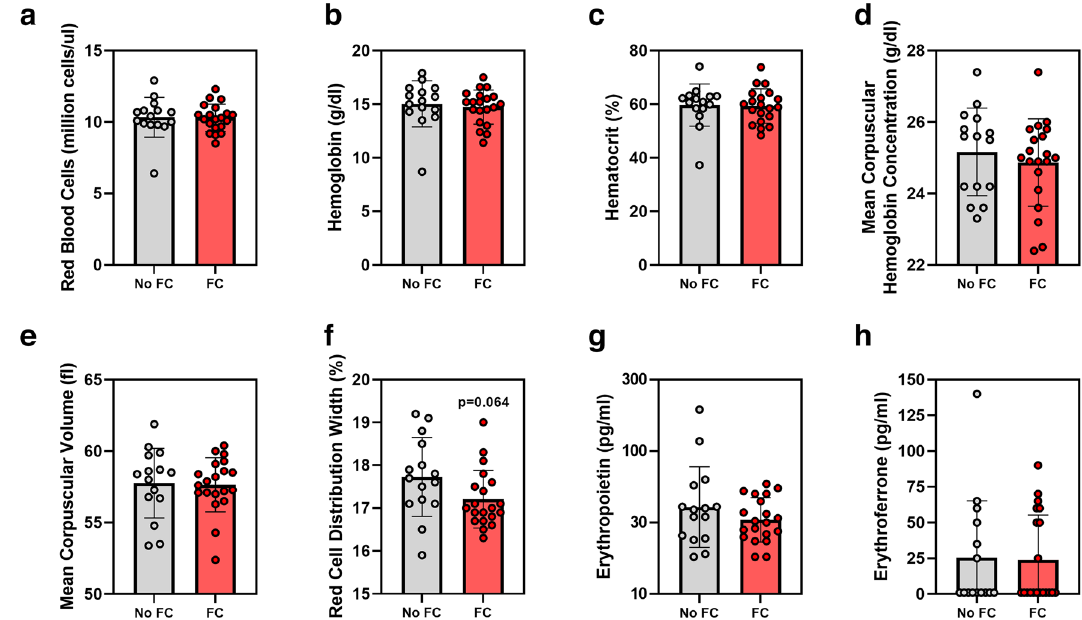
Figure 3. Erythropoietic parameters in Col4α3 knockout mice treated with or without 1% ferric citrate (FC) added to the diet. Parameters measured include: ( a ) red blood cells, ( b ) hemoglobin, ( c ) hematocrit, ( d ) mean corpuscular hemoglobin concentration, ( e ) mean corpuscular volume, ( f ) red cell distribution width, ( g ) serum erythropoietin, and ( h ) serum erythroferrone. Data are presented as means and standard deviations. Two-tailed t-tests are used to compare groups, * p < 0.05.